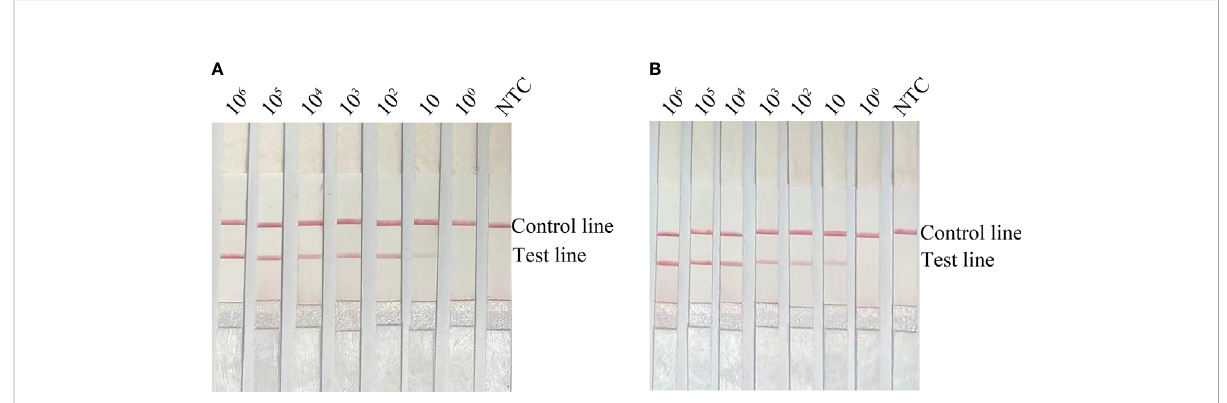
FIGURE 4 Limit of detection for the RPA-LFS method. (A) Image showing detection results with different amounts (10 6 to 10 0 CFU/µL) of E . faecalis . (B) Image showing detection results for different amounts (10 6 to 10 0 CFU/µL) of E . faecalis , 10 6 CFU/µL of E . coli O157 and 10 6 CFU/µL of E . faecium. All reactions were completed at 37°C. NTC: no template control. Image represents the results of three independent